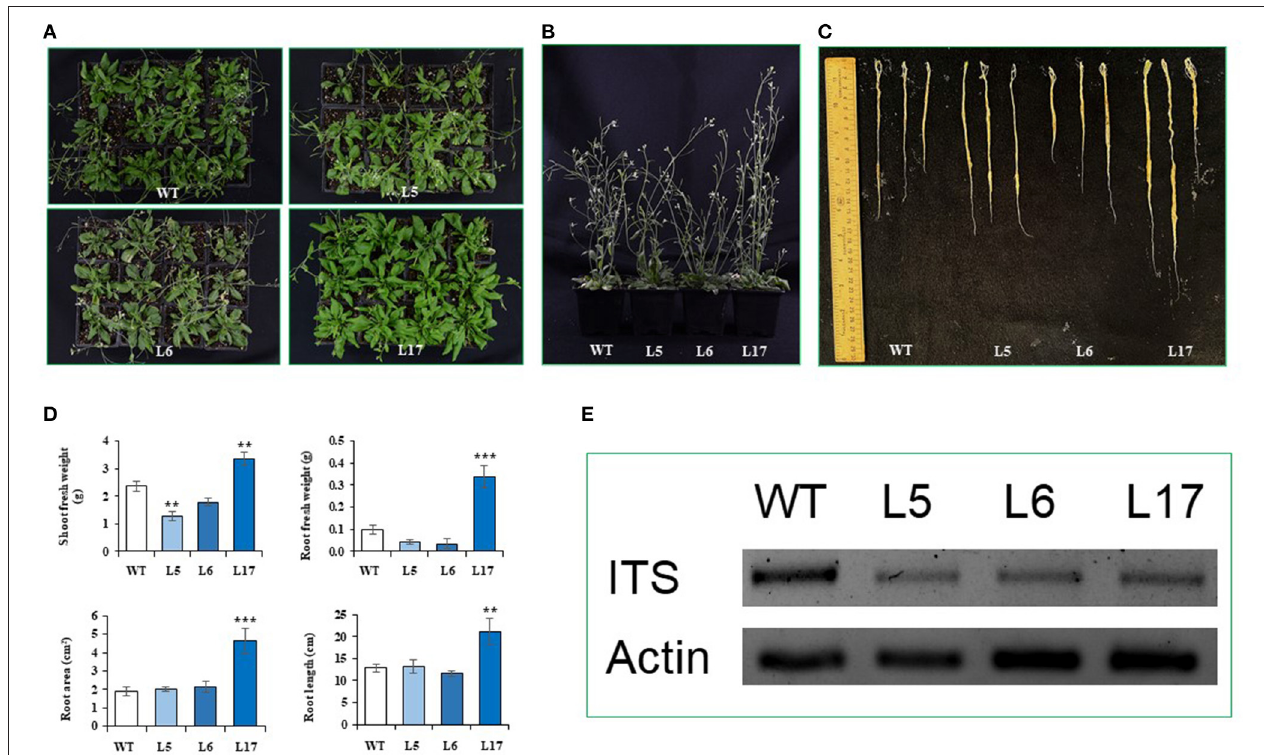
FIGURE 8 | The overexpression of the AhN4L-1 gene in transgenic Arabidopsis thaliana plants confers resistance to fungal infection in a dose-dependent manner. Growth-related parameters were differentially affected in untransformed wild-type (WT) plants compared to transgenic plant lines (L5, L6, L17) overexpressing the AhN4L-1 gene in dose-dependent manner is shown 25 days after infection, via soil drench, with a spore suspension (1 × 10 6 spores) of Fusarium oxysporum f. sp. lycopersici as shown by better (A) vegetative plant growth, (B) inflorescence height and (C) root length observed in the L17 line having the highest transgene expression levels. This was supported by data shown in (D) where root and shoot fresh weights as well as root area and root length were significantly higher in the L17 line. Here, the bars represent the mean values ± SE of these parameters obtained from five plants of each line examined. Asterisks over the bars denote significant differences at P < 0.01 (**) or P < 0.001 (***) (One-way ANOVA, Tukey-Kramer test). Three independent experiments with similar results were performed. (E) PCR amplicons obtained using the ITS1/ITS4 primers (refer to Table 1 ) and DNA extracted from roots of untransformed (WT) and transgenic (L5, L6, and L17) A. thaliana plants 25 days after infection with spores of F. oxysporum f. sp. lycopersici . The amplification of the constitutively expressed A. thaliana Actin gene was used as loading